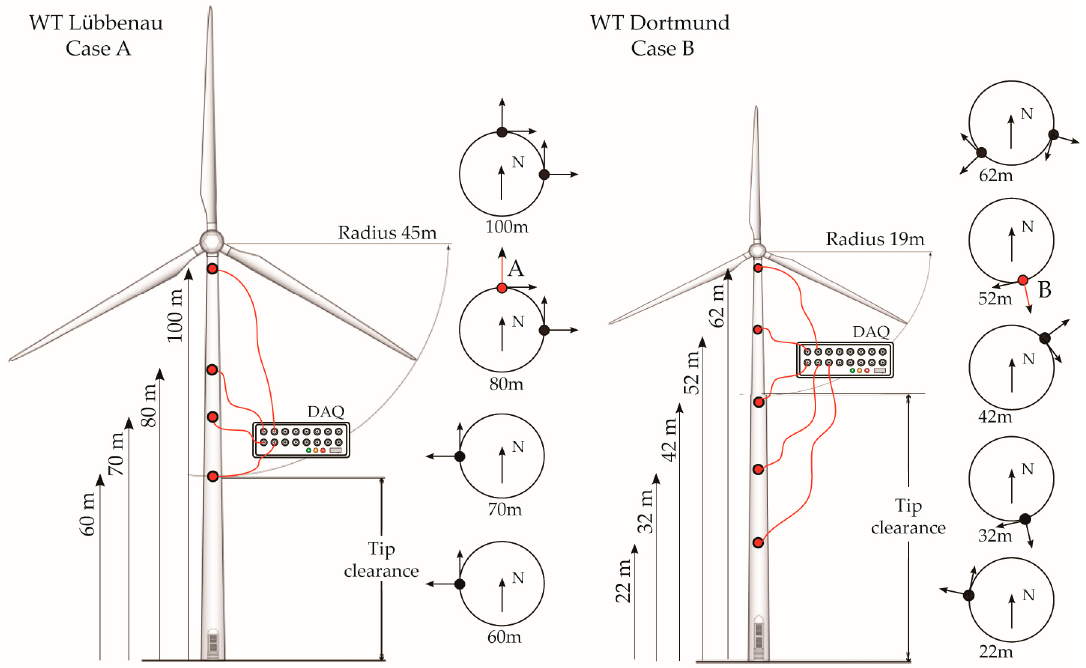
Figure 5. Schematic overview of the experimental setup (case A left and case B right).